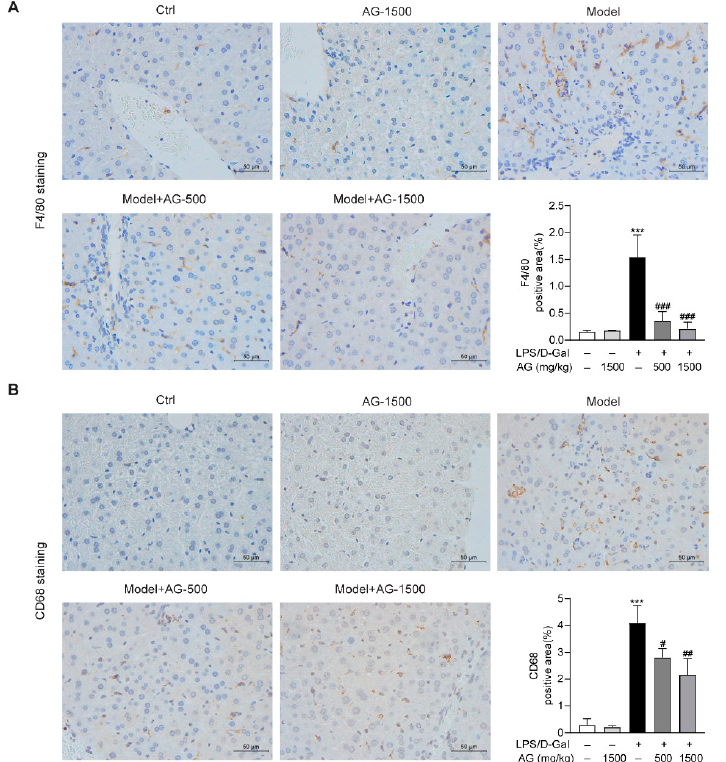
Figure 4. IHC analysis results showing the levels of F4/80 and CD68 in liver tissues in mice. ( A ) IHC staining of F4/80 of liver tissues (original magnifications, × 400), and quantitation of F4/80 positive area. ( B ) IHC staining of CD68 of liver tissues (original magnifications, × 400), and quantitation of CD68 positive area. Data are expressed as mean ± SD, n = 6–8 in each group. *** p < 0.001 vs. vehicle ‐ treated control group, # p < 0.05, ## p < 0.01, ### p < 0.001 vs. LPS/D ‐ Gal ‐ treated model group. In addition, real ‐ time PCR showed that the proinflammatory cytokines and chemo ‐ kines, including TNF ‐α , IL ‐ 1 β , IL ‐ 6, MCP ‐ 1, and RANTES, were significantly increased after LPS/D ‐ Gal treatment for 5 h, while Ala ‐ Gln pretreatment markedly reduced the ex ‐ pression of these proinflammatory factors (Figure 5A–E). Similarly, ELISA assays also in ‐ dicated a significant upregulation of plasma proinflammatory cytokines in mice that had been injected with LPS/D ‐ Gal, while Ala ‐ Gln dramatically decreased these elevations (Fig ‐ ure 5F–J).